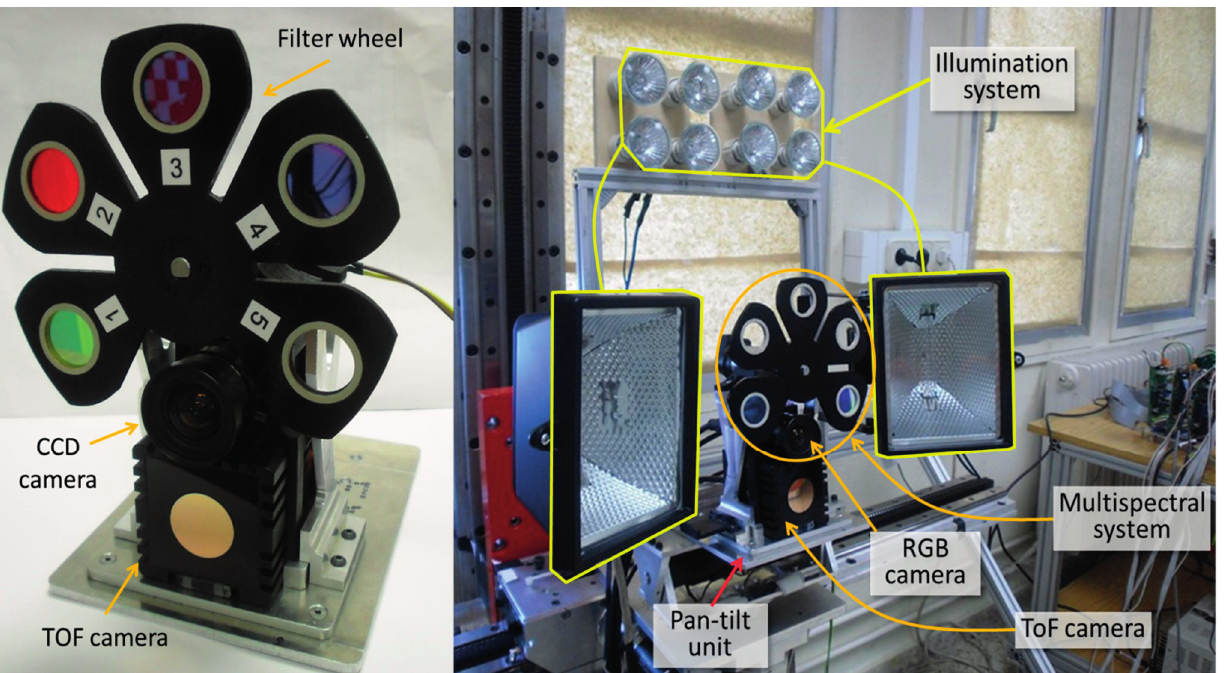
Figure 1. Close-up views of the multisensory system for fruit harvesting